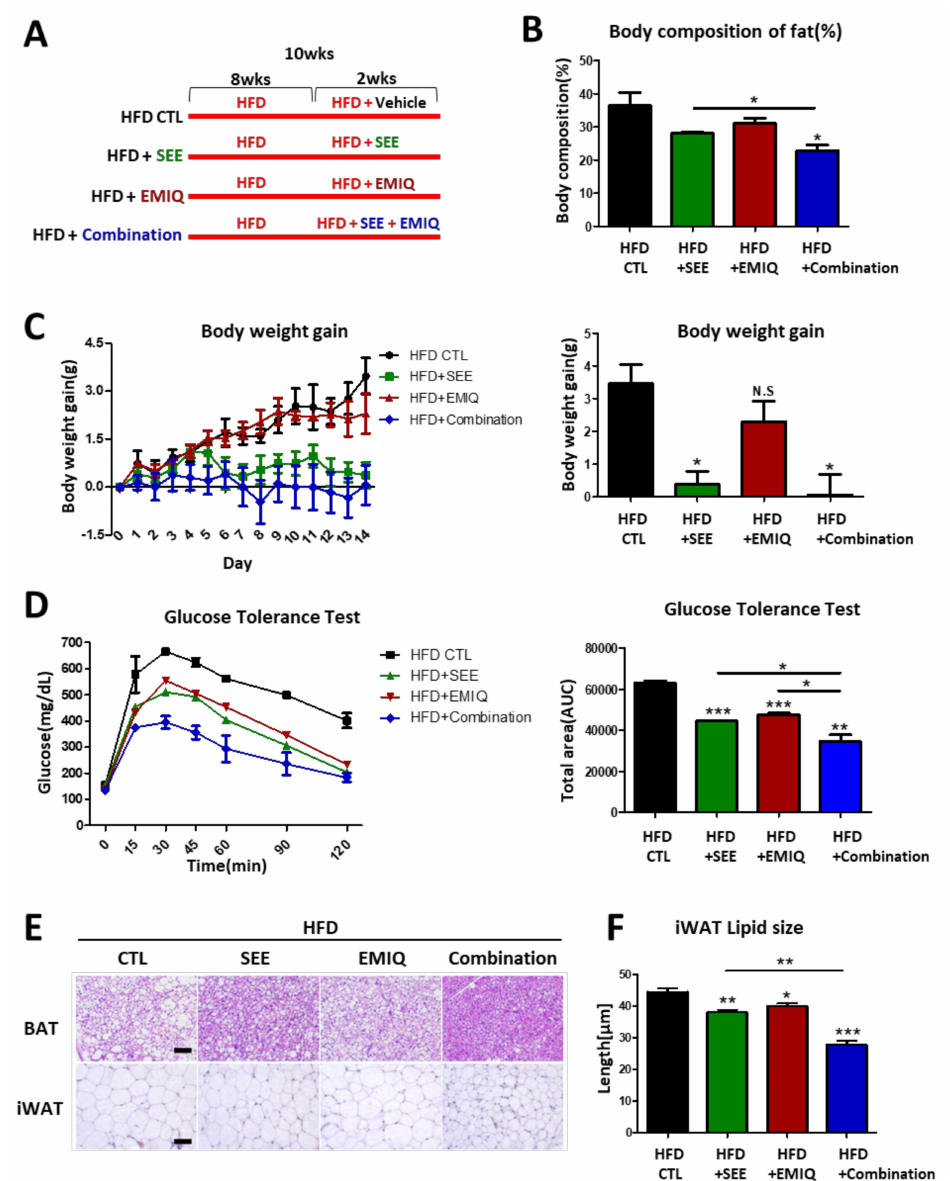
Figure 4. E ff ects of in vivo SEE, EMIQ, and co-treatment (SEE + EMIQ) treatment on body weight and glucose tolerance of mice fed with a high fat diet. ( A ) Study design for 8 weeks of high fat diet feeding and two weeks of high-fat diet(HFD) + Control vehicle, SEE (400 mg / kg), EMIQ (100 mg / kg) and Combination (SEE 400 mg / kg + EMIQ 100 mg / kg) treatment. ( B ) Body composition of fat percentage. ( C ) Body weight gain monitoring while two weeks of HFD + SEE, EMIQ, Combination (SEE + EMIQ) treatment. ( D ) Glucose tolerance test. ( E ) Hematoxylin and eosin(H / E) staining of para ffi n section